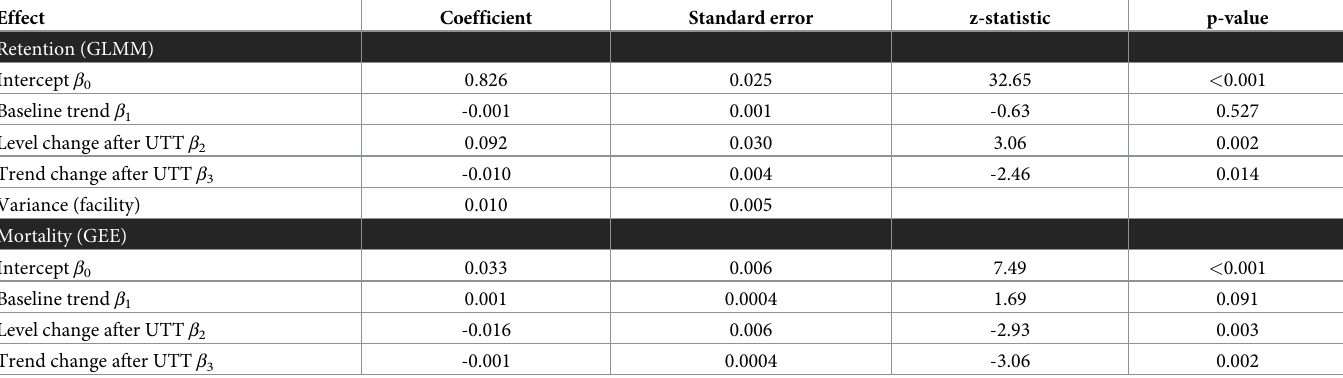
Table 2. Parameter estimates, standard errors and p-values from the segmented regression models predicting six-month retention and mortality among PLHIV enrolled in the 11 TASO health facilities between 2015 and 2018.